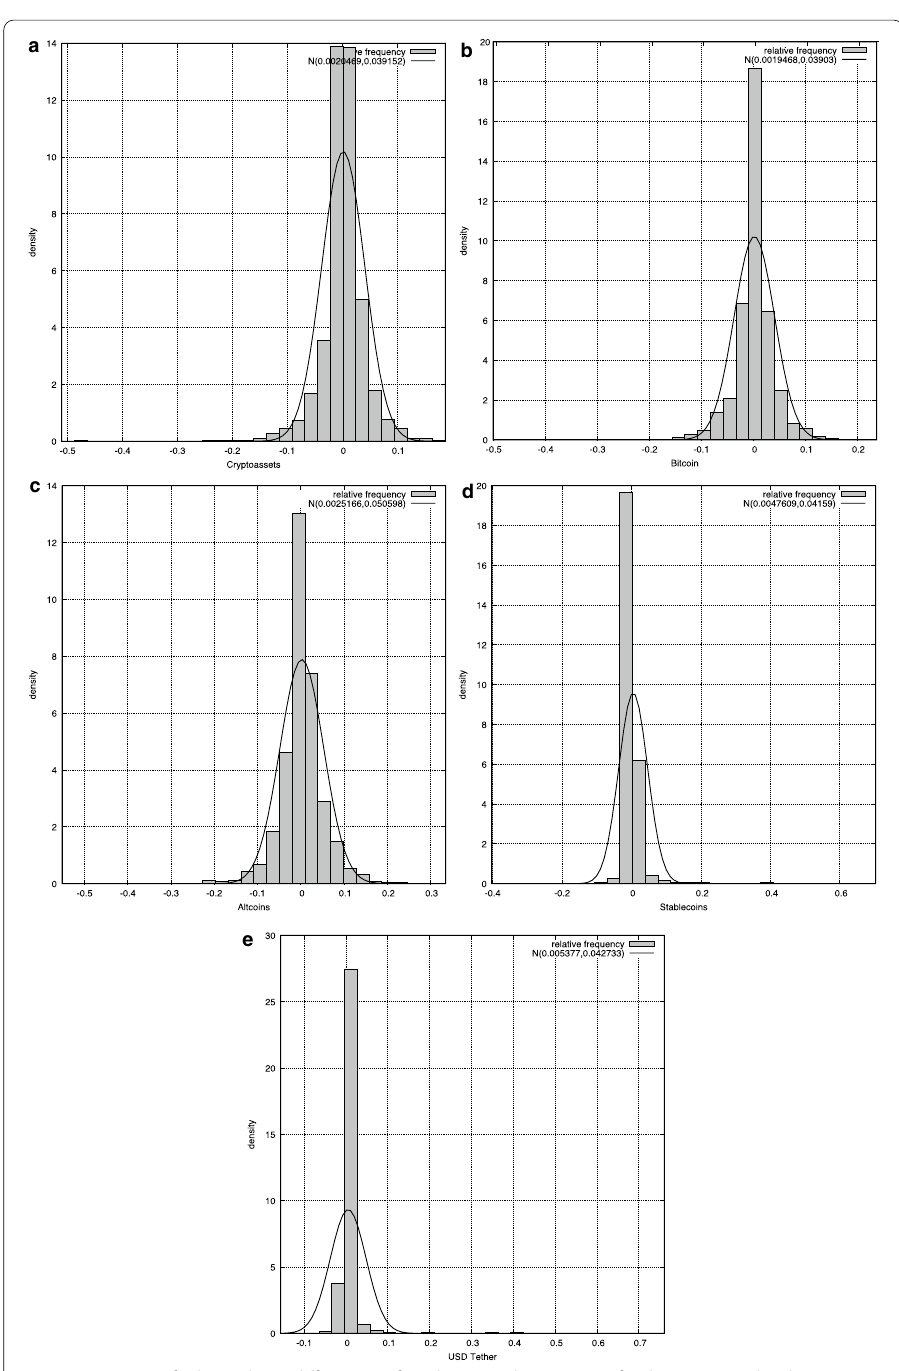
Fig. 4 Histograms for logarithmic differences of market capitalizations. Fits for the Gaussian distribution are shown as well representing the variables cannot be described as Gaussian as each variable has a set of extreme observations and their bulk is more concentrated around the mean value than what would be expected for Gaussian variables, i.e., behavior closer to the stable distributions, all in hand with Table